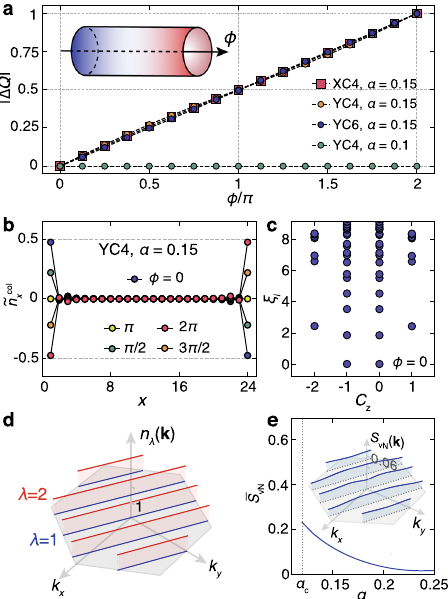
Fig. 3 Quantized hall conductance and QAH state. In the systems of both width W = 4, 6, a fl ux ϕ ∈ [0, 2 π ] is threading through the cylinder, a One electron is pumped from one edge to the other for α = 0.15 (QAH phase), while no charge response is observed for α = 0.1 (stripe phase). b In the real-space charge distribution of YC4 cylinder, no accumulations are observed in the bulk, i.e., only the charge near the left edge is pumped. c Entanglement spectrum computed at the central bond (between two columns) shows a two-fold degeneracy. For a typical QAH state with α = 0.25, we show in d the charge density n λ ( k ), with λ labeling the two eigenvalues of the 2 × 2 ~ G ð k Þ matrix associated with two sublattices. In e the von Neumann Entropy (cid:2) S vN averaged over all the k points, is shown versus α , where the S vN distribution in BZ is shown in the inset (with also α =